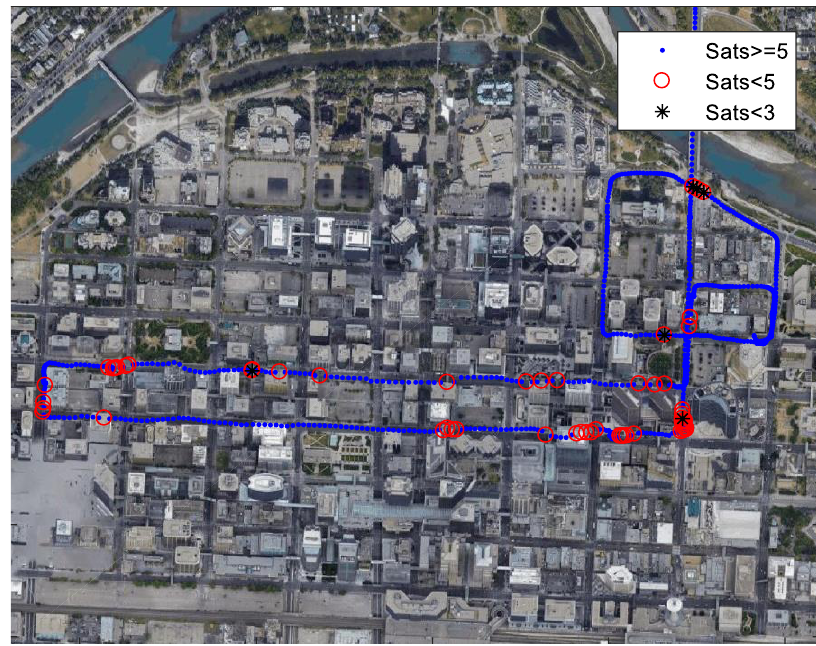
Figure 14. Test trajectory in Calgary ’s downtown.